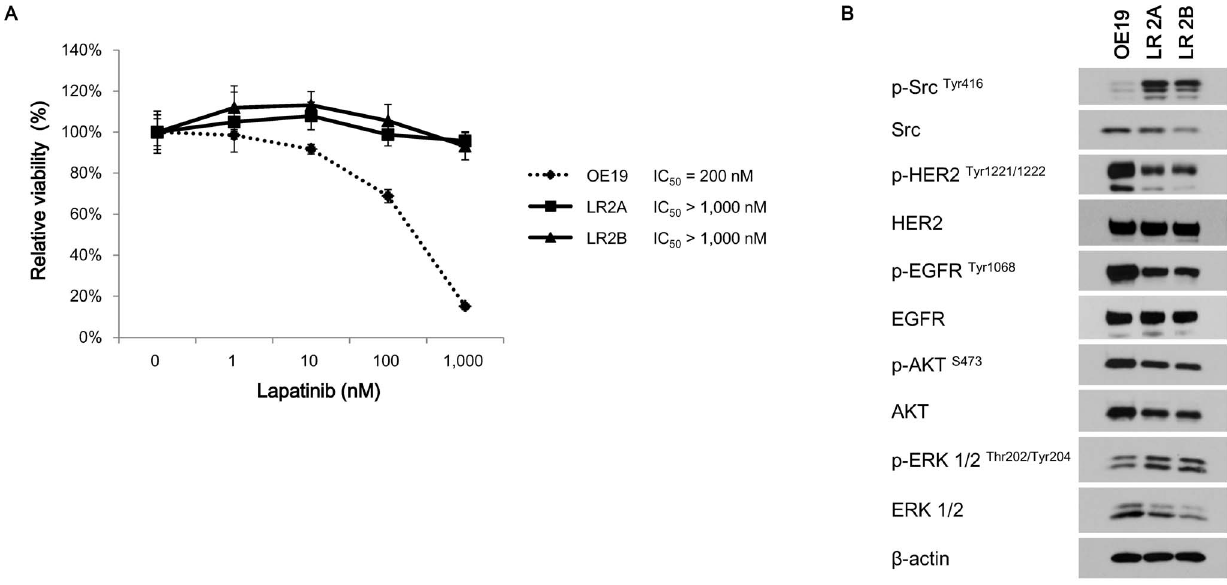
Figure 2. Comparisons of lapatinib sensitivities and the baseline signalling proteins activities between parental and lapatinib- resistant subclones. A, Lapatinib sensitivity curves in the parental OE19 and two lapatinib-resistant (LR) subclones. The calculated values of IC 50 of lapatinib were 200 nM in parental cells and . 1,000 nM in two LR subclones. Values were presented as relative cellular viability relative to vehicle- treated controls with the mean 6 S.E. of quadruplicate from a representative experiment. The p values were , 0.0001 for OE19 vs LR2A and OE19 vs LR2B, and was 0.129 for LR2A vs LR2B. The p values were calculated by two-way ANOVA. B, Immunoblots showing the phosphorylations of distinct signalling molecules in parental OE19 cells and the Src -mutant lapatinib-resistant